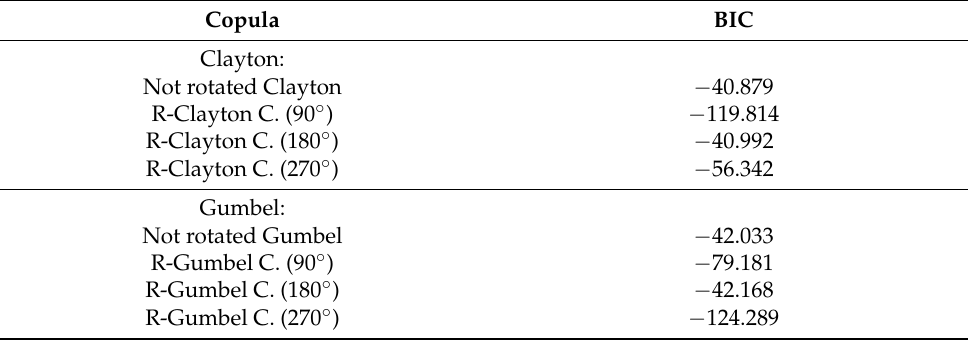
Table 1. Type of Clayton and Gumbel copula selection.